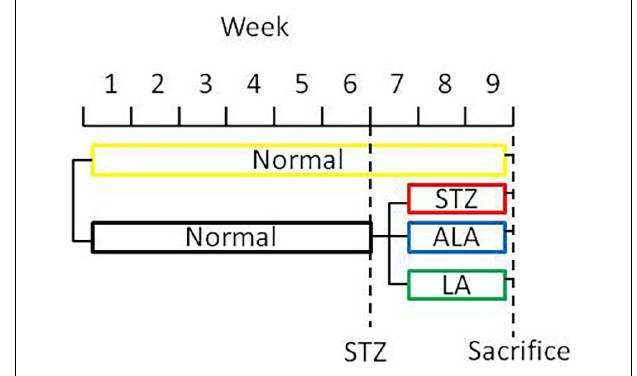
FIGURE 1 | A scheme showing the experimental protocols used in the induction of diabetes and treatment with EFAs (ALA and LA).